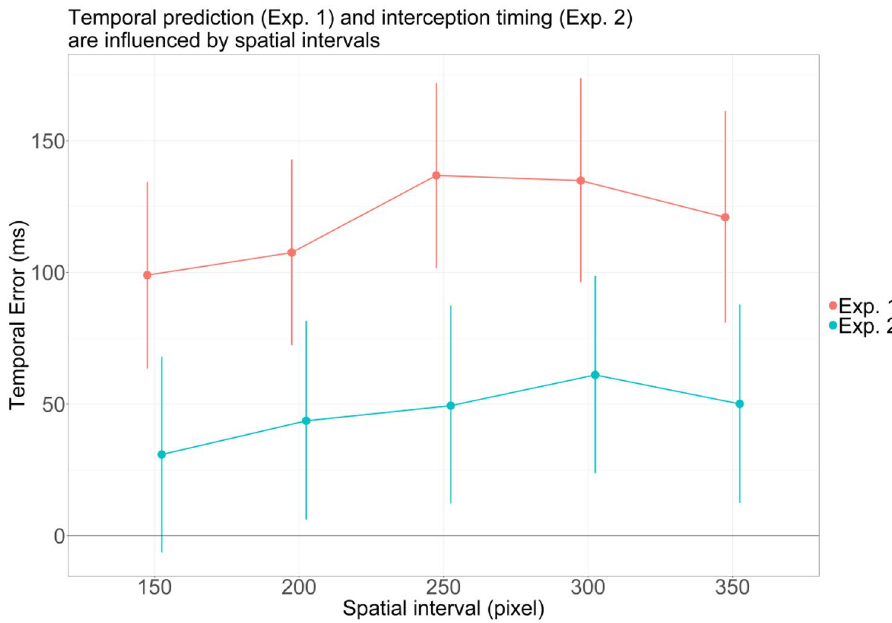
Figure 2. Model estimates (mean and 95% CrI) of the temporal error for the different spatial intervals for Exp. 1 and Exp. 2. Positive values indicate that the response was longer compared to the temporal ISI. Red: Results of Exp. 1 on temporal prediction: Participant’s response times slowed down for a distance between 150 to 250 pixels when the spatial distance increased (kappa effect). Blue: Results of Exp. 2 on interception timing: Participants reacted later when the distance increased (kappa effect), except for the 350 px interval.